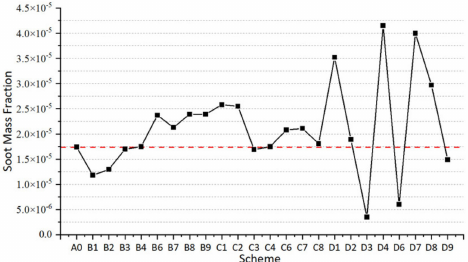
Figure 48. Soot mass fraction distribution of each optimized design